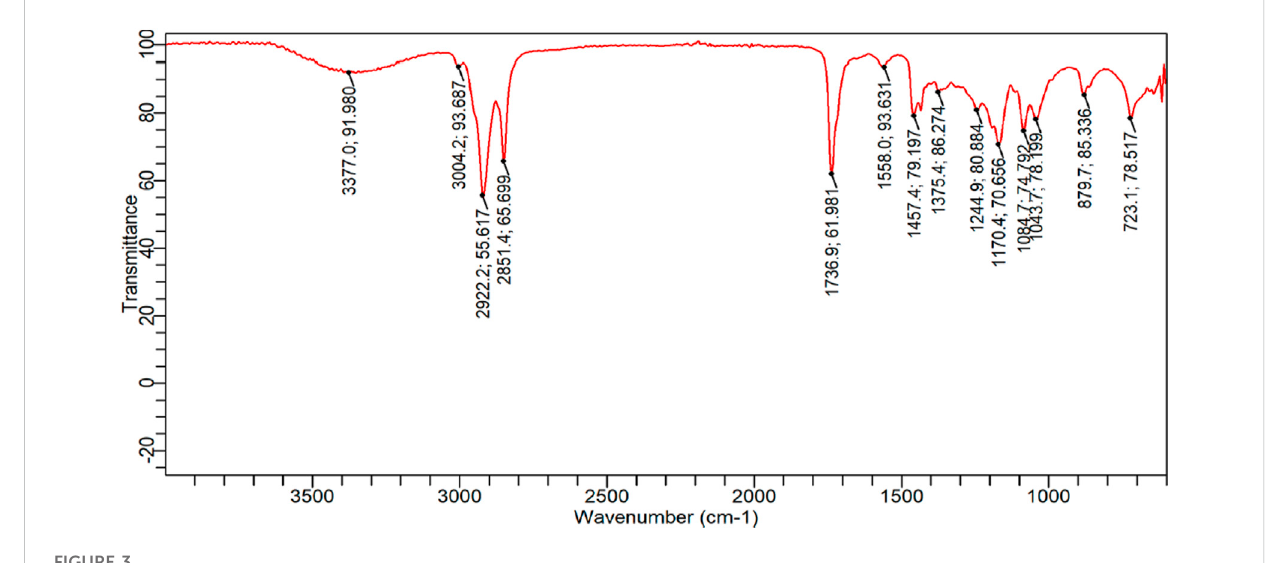
FIGURE 3 FTIR Spectrum of synthesized